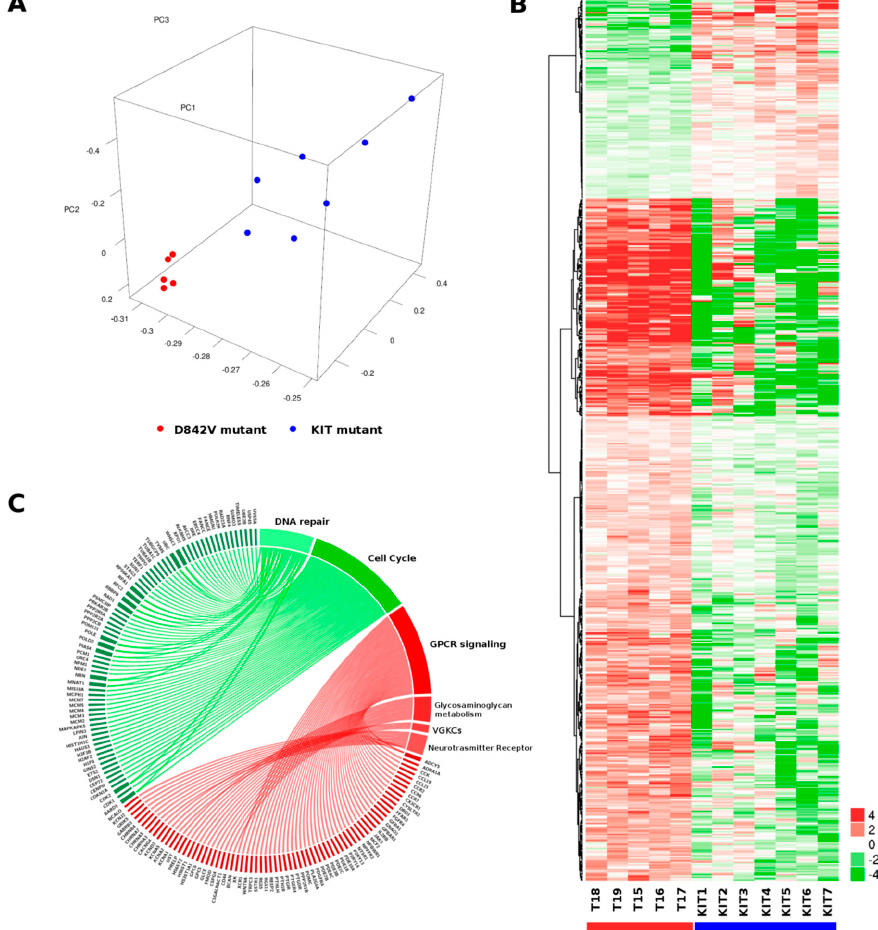
Figure 1. Transcriptome profile of D842V mutant versus KIT mutant GIST. ( A ) Principal component analysis performed on the whole set of expressed genes ( n = 15,134) shows a very uniform profile of D842V mutant tumors (red dots) that is distinctly separated from KIT mutant GIST (blue dots); ( B ) Heatmap of 494 overexpressed and 144 downregulated genes in D842V GIST; hierarchical clustering was performed to groups genes adopting Manhattan distance and Ward method; ( C ) Graphical representation of genes and pathways emerging as enriched (red) or depleted (green) in D842V mutant GIST. Genes and the corresponding pathways are also reported in Supplementary Table S2.